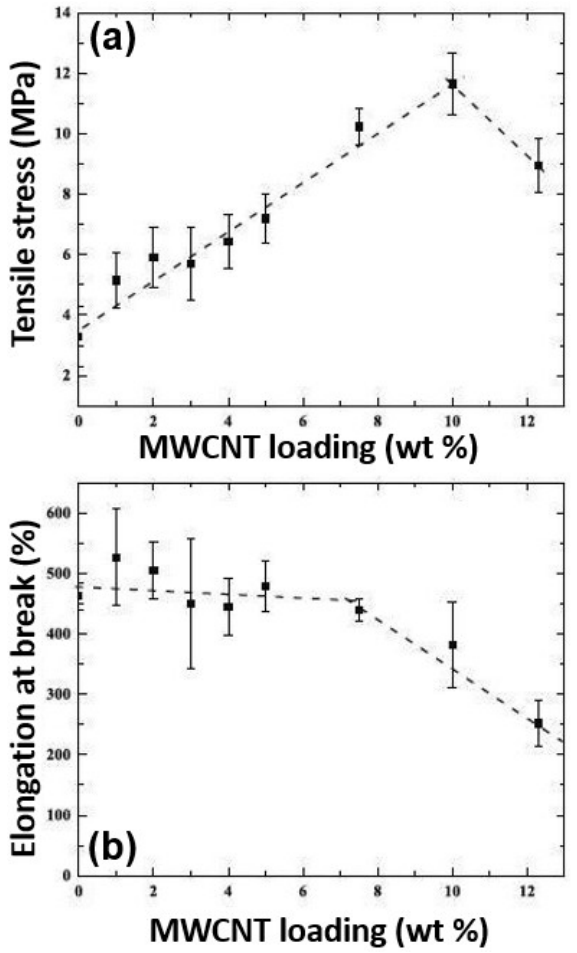
Figure 6. ( a ) Tensile stress at break; ( b ) elongation at break as a function of MWCNT loading. Reproduced with permission from [69], Copyright Elsevier, 2015.